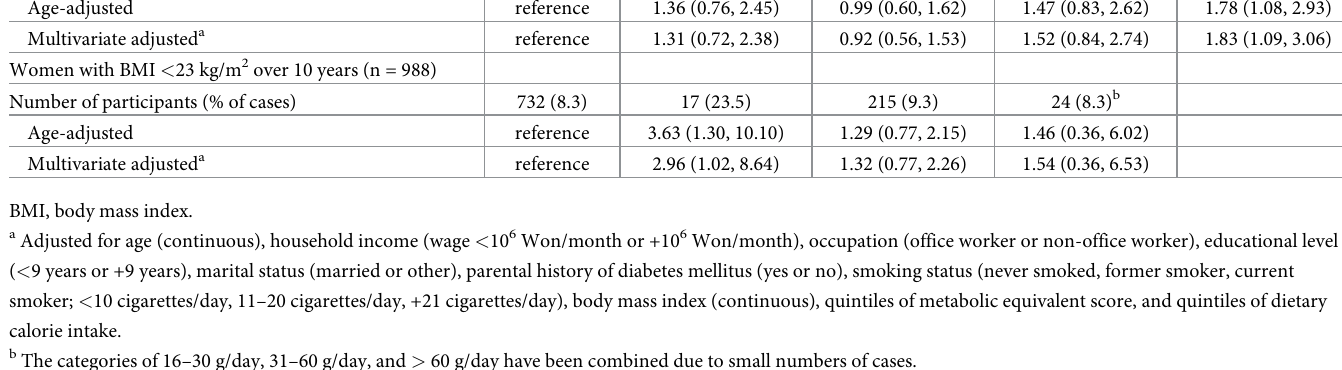
activity level had a 46% (95% CI: 19%, 64%) reduction in the risk of T2DM. Those with a parental history of DM, as well as those with alcohol consumption � 16 g/day, were found to